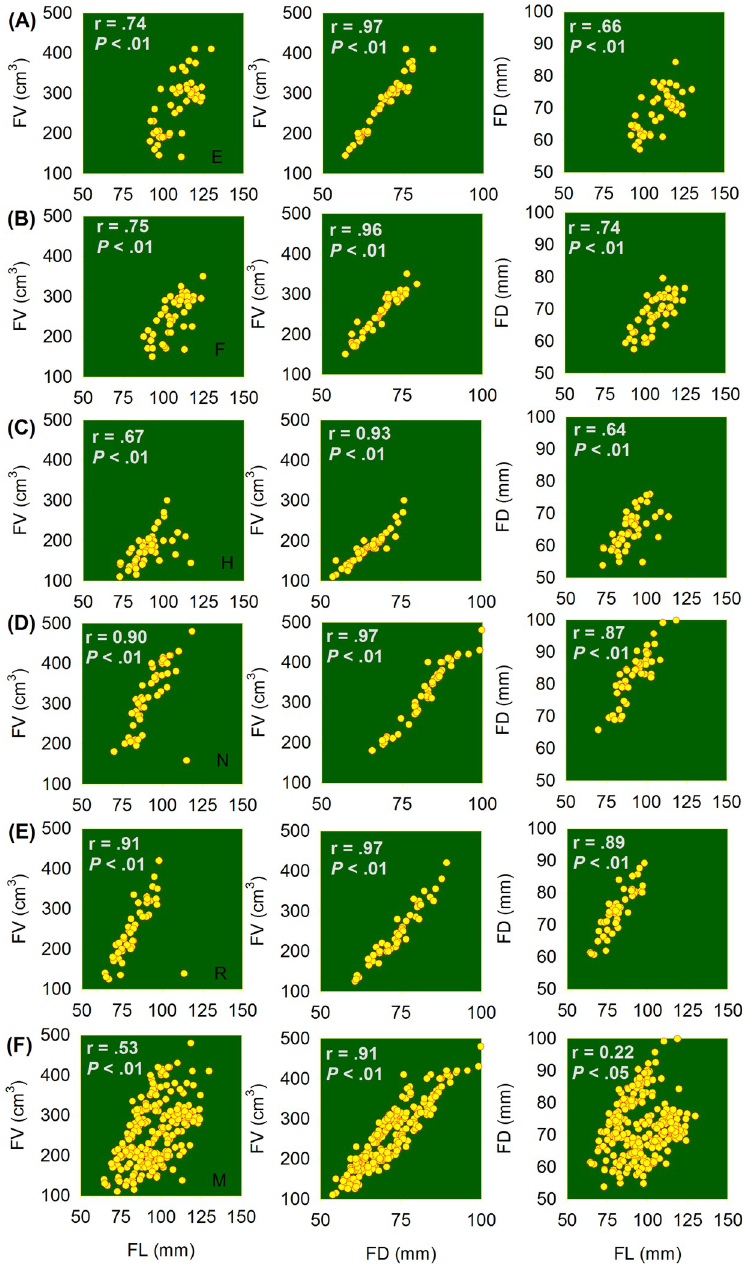
Fig 3. Fruit volume as a function of fruit length, diameter, and regression of fruit diameter as a function of fruit length. On Fig 3, the letter E, F, H, N, R and M refers Ettinger, Fuerte, Hass, Nabal, Reed and Mixed cultivar data.